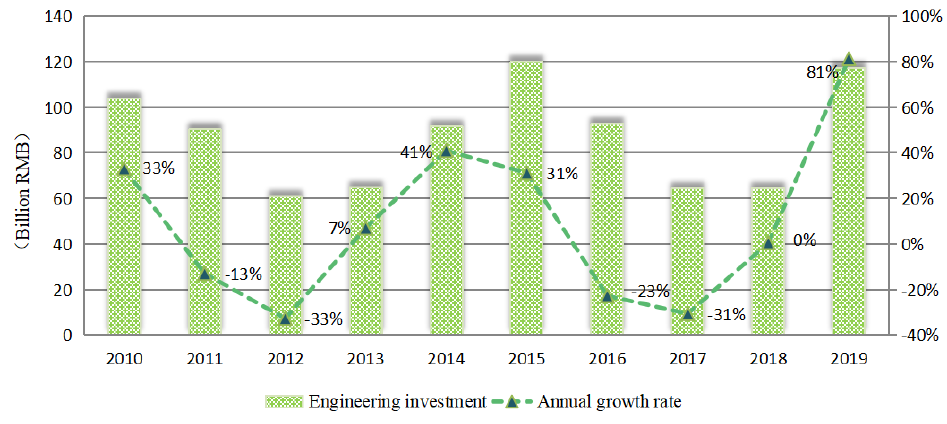
Figure 7. Annual investment of China’s wind power in 2010–2019.